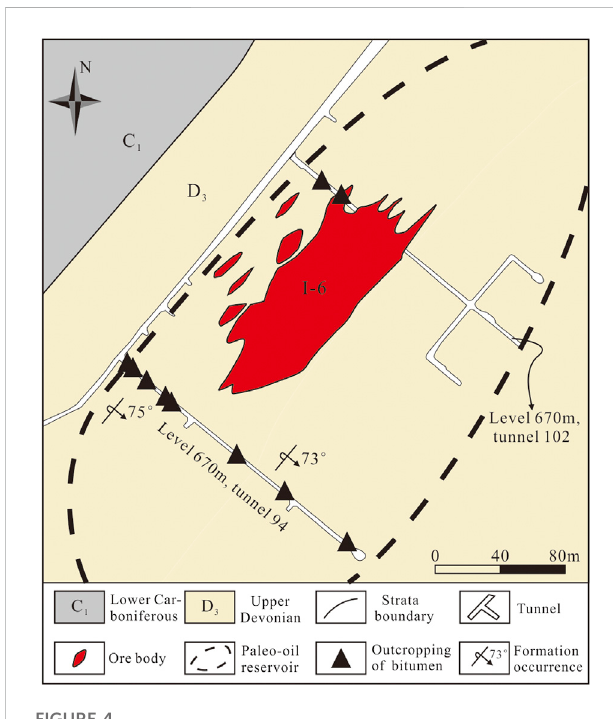
FIGURE 4 Distribution map of orebody and paleo-oil reservoir in level 670 m, Maoping